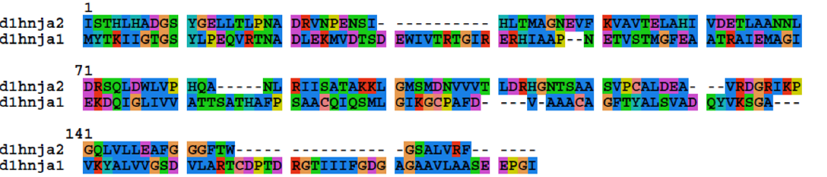
Figure 8. Structure models of d1hnja2 (Beta-Ketoacyl-acyl carrier protein synthase III) based on d1hnja2-d1hnja1 alignment (Reference TM = 0.5988, ID = 10.4%) from CRFalign ( top left , red) with TM-CRFalign = 0.5768, and HHalign ( top right , cyan) with TM-HHalign = 0.4862; at the top center (yellow) is the native structure. The bottom figure shows the CRFalign alignment.